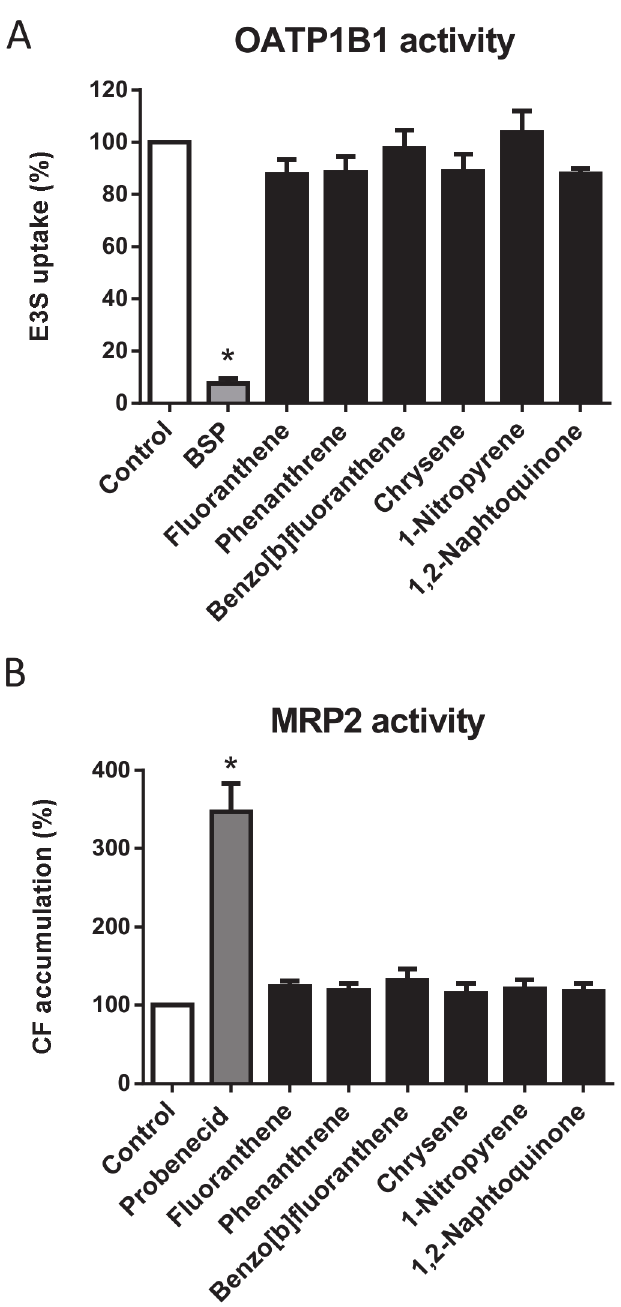
Fig 4. Effects of various DEPe-contained PAHs on OATP1B1 and MRP2 activity. (A) OATP1B1- mediated transport of E3S was determined in OATP1B1-transfected CHO cells in the absence or presence of the reference OATP inhibitor bromosulfophtalein (BSP) (100 μ M) or of various DEPe-contained PAHs or PAH derivatives, each being used at 10 μ M. Data are expressed as % of E3S accumulation in control untreated cells and are the means ± SEM of three independent assays. * , p < 0.05 when compared to control cells (ANOVA followed by a Dunnett ’ s post-hoc test). (B) Accumulation of the MRP2 substrate CF was measured in HuH-7 cells in the absence or presence of DEPe (25 μ g/mL) or of various DEPe-contained PAHs or PAH derivatives, each being used at 10 μ M. Data are expressed as % of CF accumulation in control untreated cells and are the means ± SEM of three independent assays. * , p < 0.05 when compared to control cells (ANOVA followed by a Dunnett ’ s post-hoc